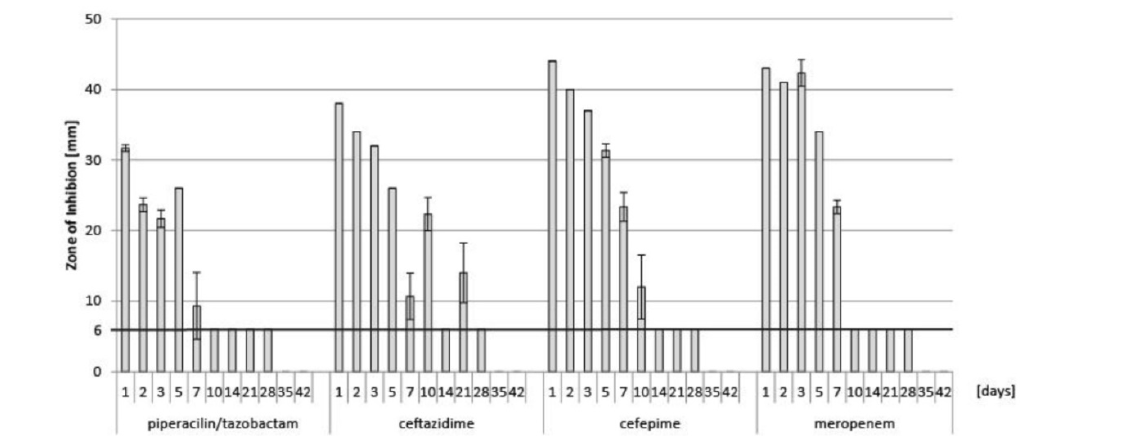
Figure 2. Results from determination of antibacterial activity of piperacillin-tazobactam, ceftazidime, cefepime and meropenem by disc diffusion test from the test series in PBS. Piperacillin and tazobactam had to be tested in combination for this assay. Data are presented as means of triplicates of the diameter of the zone of inhibition in mm, with error bars indicating standard deviation. The horizontal line at 6 mm indicates the diameter of the paper